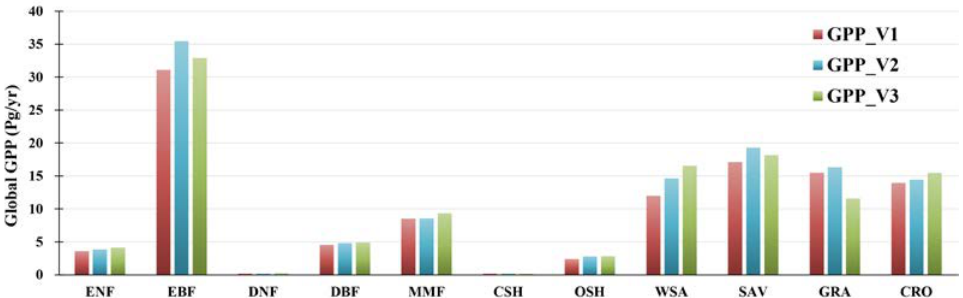
Figure 10. Global GPP in each type of vegetation. V1: Parameterization approach without the CI; V2: Parameterization approach with the CI; V3: Cubist regression tree approach. 506